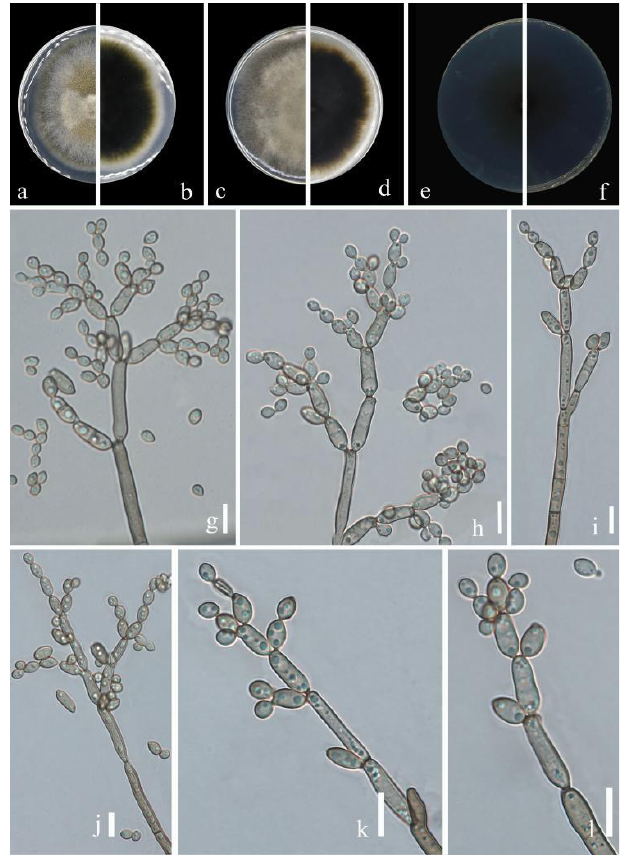
Figure 6. Cladosporium wenganensis (HGUP 21220, holotype). ( a , b ) Culture on PDA from above